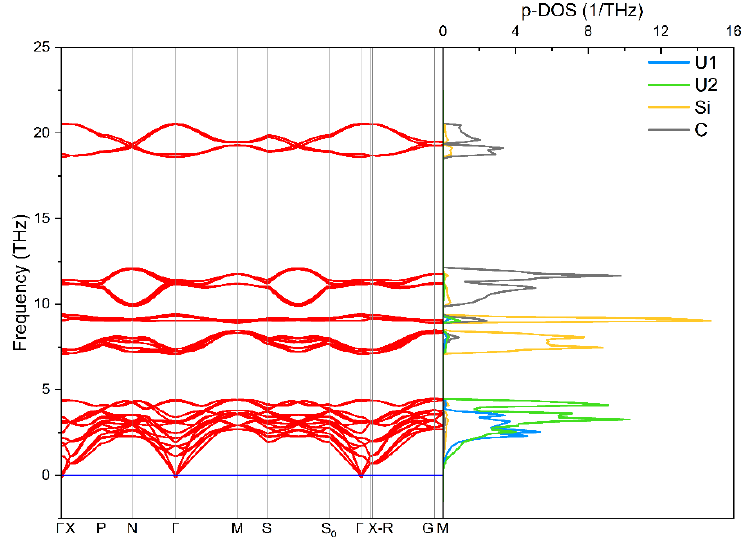
Figure 2. The phonon dispersion curves and the phonon density of states (p-DOS) for U 3 Si 2 C 2 . The mechanically stability of U 3 Si 2 C 2 can be judged by elastic constants. For the tetragonal (I) symmetry, there exists six independent elastic constants, namely C 11 , C 12 , C 13 , C 33 , C 44 , and C 66 [54], and the calculated elastic constants are listed in Table 2. All elastic constants obey the elastic stability criteria list as the Equation (11), proving this specific crystal is mechanically stable.